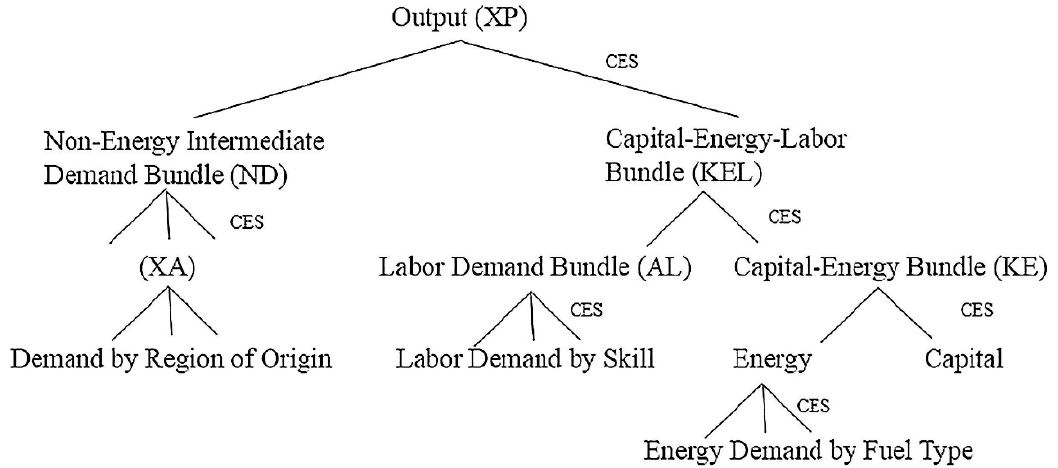
Figure 1. PANDA model production block.